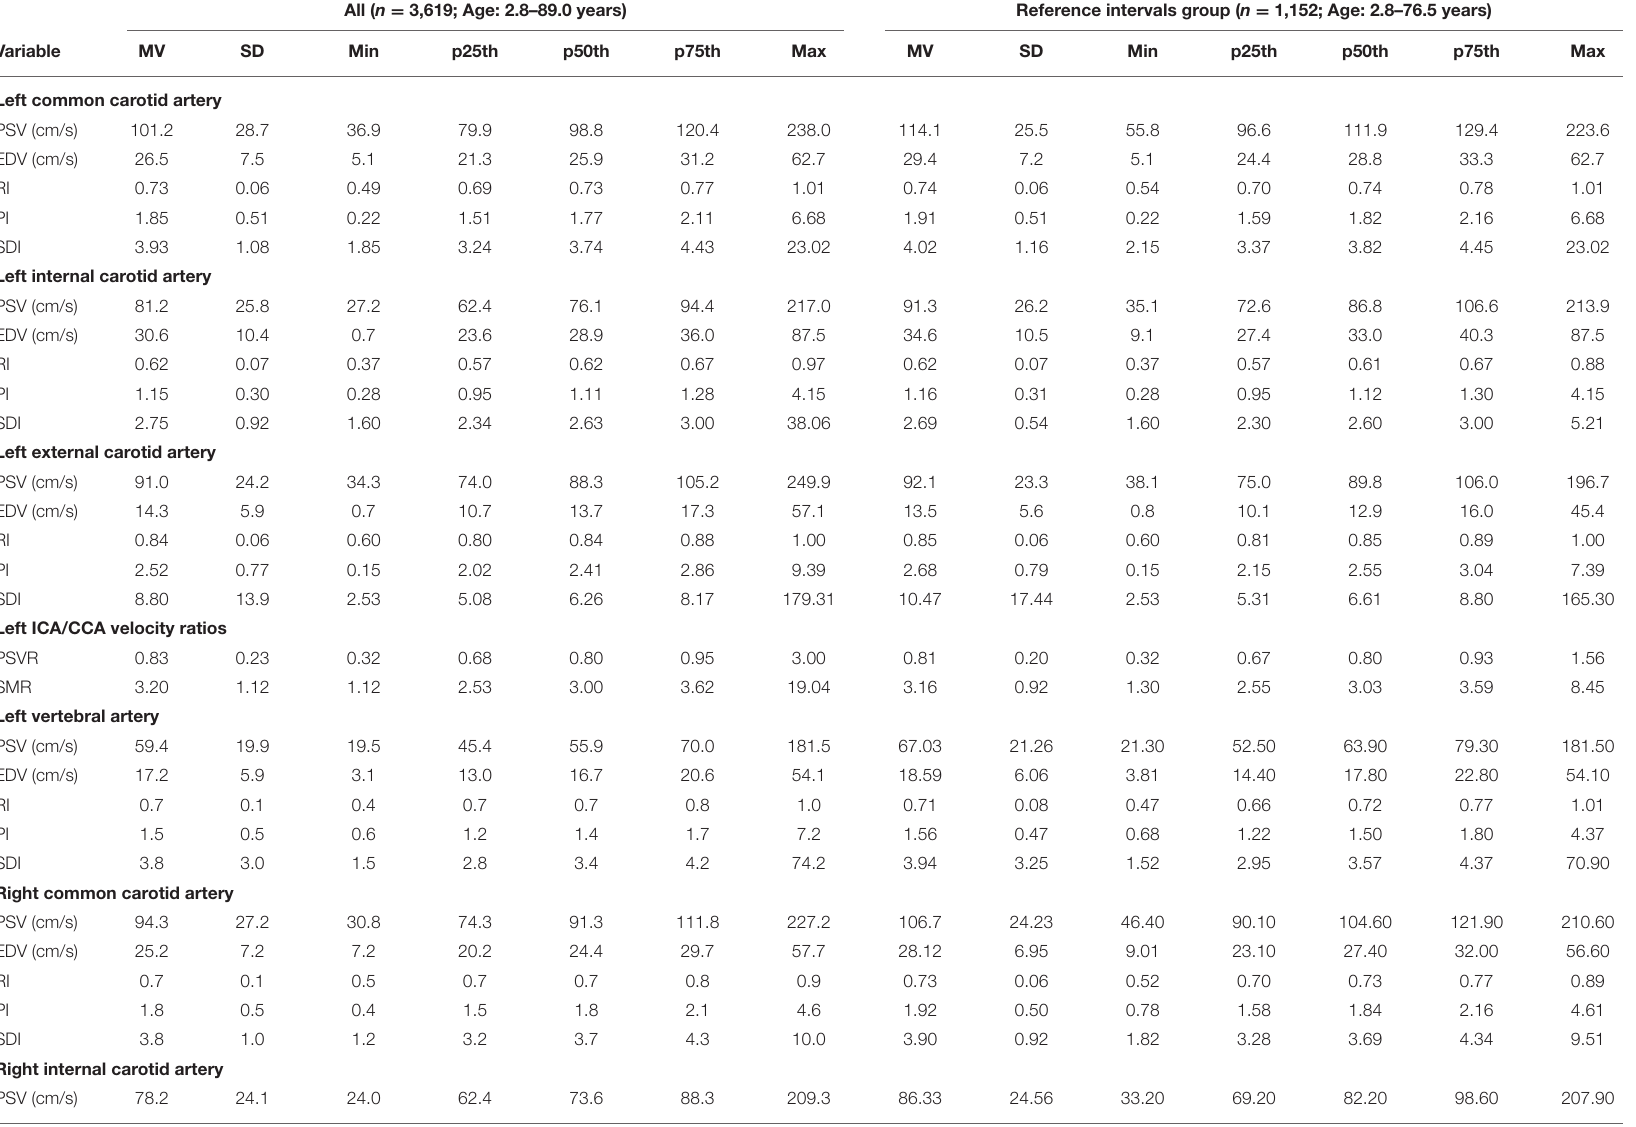
TABLE 3 | BFV parameters and derived indexes.